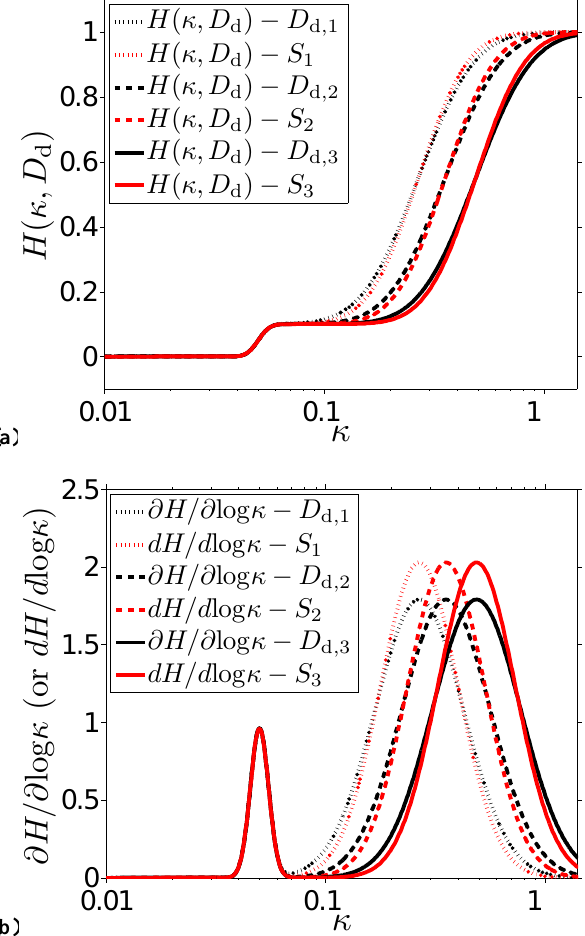
Fig. 6. Cumulative particle hygroscopicity distributions, H(κ,D d ) (a) , and corresponding logarithmic probability distributions, ∂H(κ,D d )/∂ log κ or dH(κ,D d )/d log κ (b) , for the model aerosol of Case C obtained by method I (“ S scan” at D d , 1 , D d , 2 or D d , 3 ) and method II (“ D d scan” at S 1 = 0.86%, S 2 = 0.26% or S 3 =